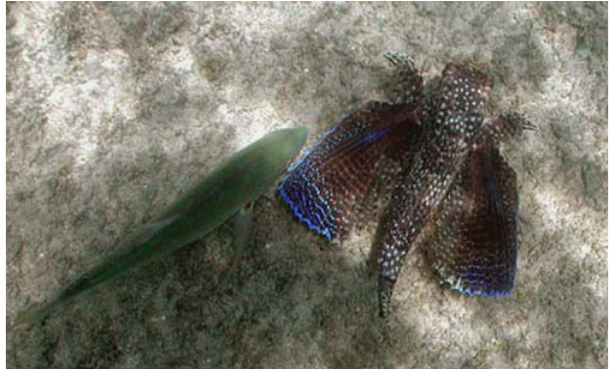
Fig. 1. The flying gurnard ( Dactylopterus volitans ; 20 cm TL) wandering close to the gravel substrate with its characteris- tic dotted coloration, escorted by a yellow jack ( Caranx bartholomaei ; 25 cm